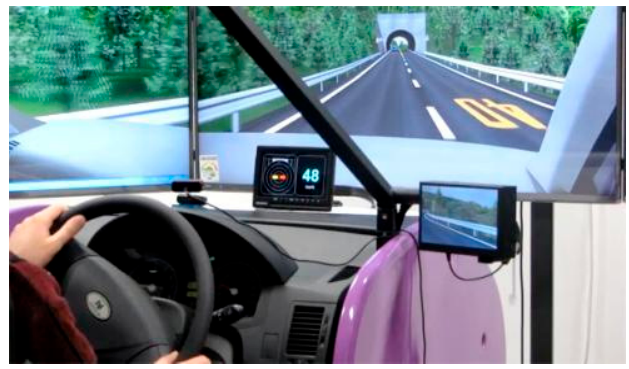
Figure 2. Experimental environment: full-scale Forum-8 drive simulator.